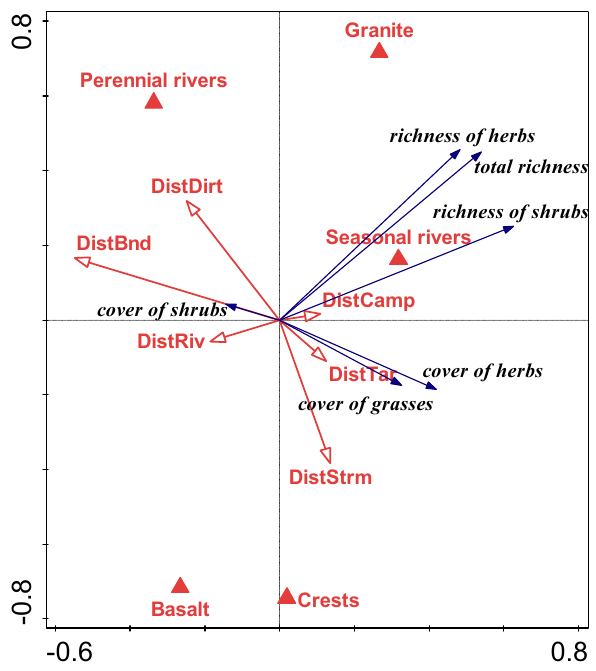
Figure 8. The relationships of the large-scale factors and measures of plant richness and cover in the sampled plots after filtering out the effects of (i) bedrock (basalt, granite), water availability (perennial river, seasonal river, crest) and arrangement of individual plots into triplets; and (ii) the spatial arrangement of plots (expressed by the PCO1, PCO2 and PCO3 coordinates). The correlations between individual variables are expressed by the directions of the corresponding arrows. Arrows aiming in the same or similar directions are positively related, while variables represented by arrows aiming in the opposite directions are negatively related. Rectangular angle between two arrows shows no relation, at least in the dimensionality shown by the plot.